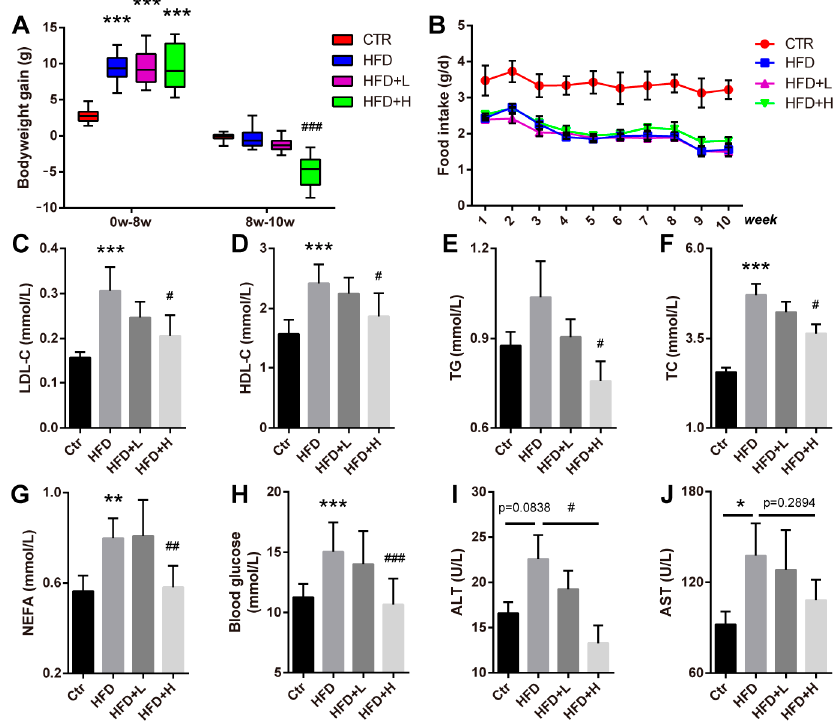
Figure 2. Anti-obesity effects of SMRR polysaccharide. ( A ) Quantification shows the bodyweight gain of the mice during the 0 − 8 w and 8 − 10 w in the experiment. Error bars indicate Mix to Max; n = 10 for CTR group, n = 12 for HFD group, n = 14 for HFD+L and HFD+H group; “*” stands for CTR vs. HFD, “#” stands for HFD vs. HFD+H; *** or ### p < 0.001 by one-way ANOVA. ( B ) Quantification shows the food uptake of mice from different groups. Error bars indicate SD. ( C – H ) Quantifications show the serum levels of LDL-C ( n = 6), HDL-C ( n = 6), TG ( n = 6), TC ( n = 6), NEFA ( n = 4) and fasting blood glucose ( n = 10 for CTR group, n = 12 for HFD group, n = 14 for HFD+L and HFD+H group) in the mice of different groups. Error bars indicate SD; * or # p < 0.05, ** or ## p < 0.01, *** or ### p < 0.001 by one-way ANOVA. ( I , J ) Quantifications show serum activity of ALT and AST in the mice of different groups. Error bars indicate SD; * or # p < 0.05, by one-way ANOVA; n = 4.